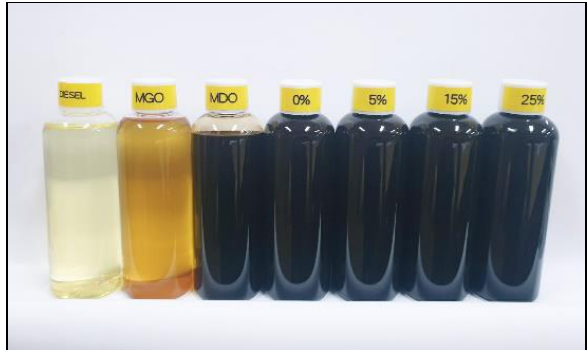
Figure 4. Comparison of water-emulsified oil samples.